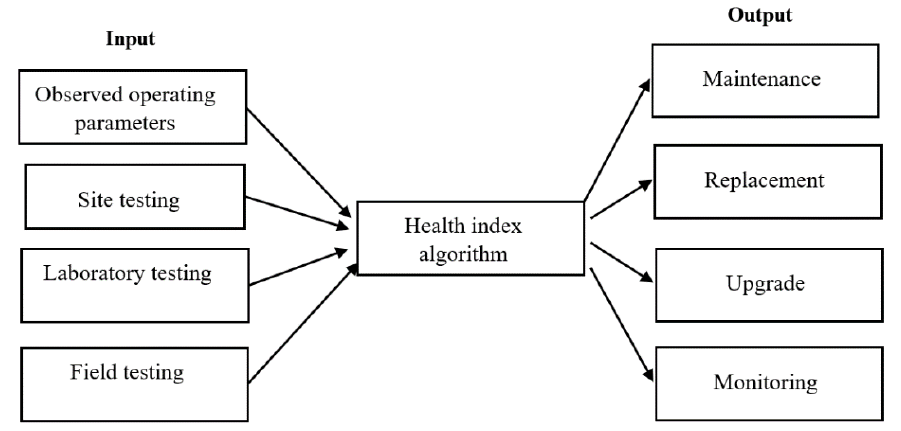
Figure 2. The structure of the health index calculation method.